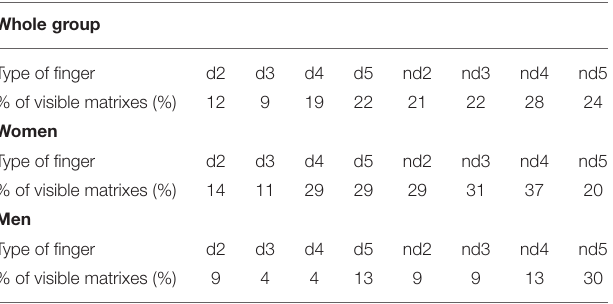
TABLE 1 | Percentage results of imaged matrixes.